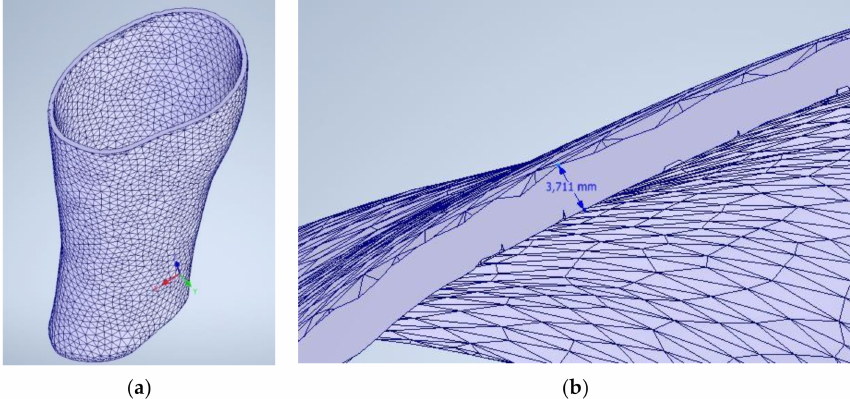
Figure 7. Splint imported from Inventor Autodesk Software ( a ) and dimensional check ( b ).